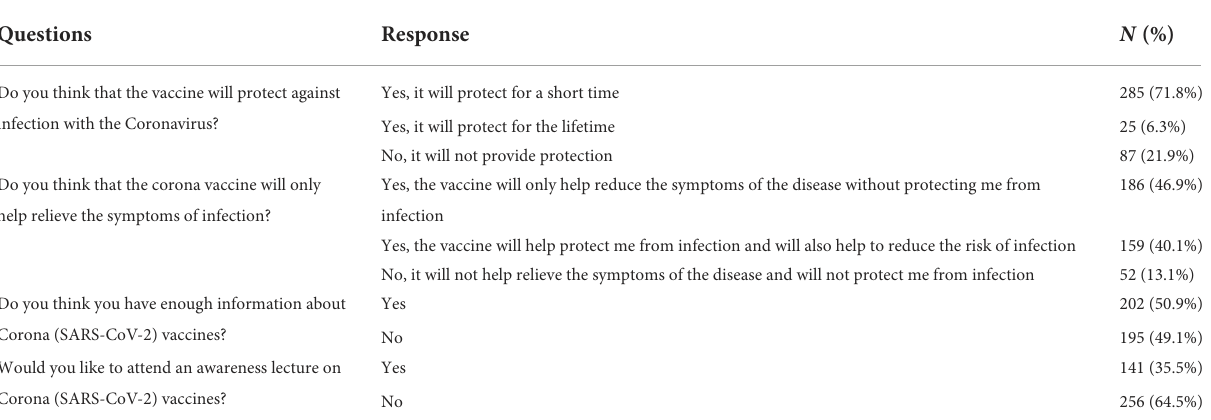
TABLE 4 Patients’ opinions toward COVID-19